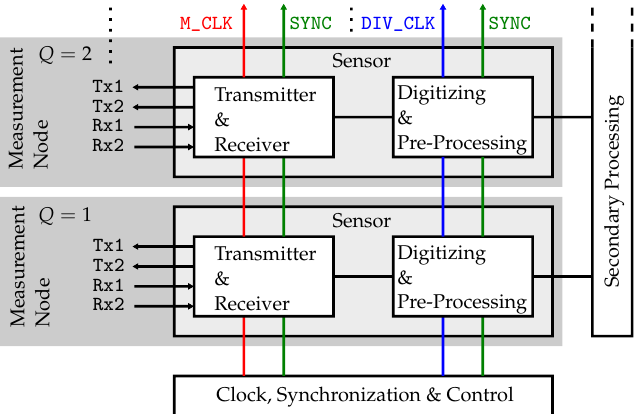
Figure 4. Distribution of clock and synchronization signals in a generic multinode imaging sensor